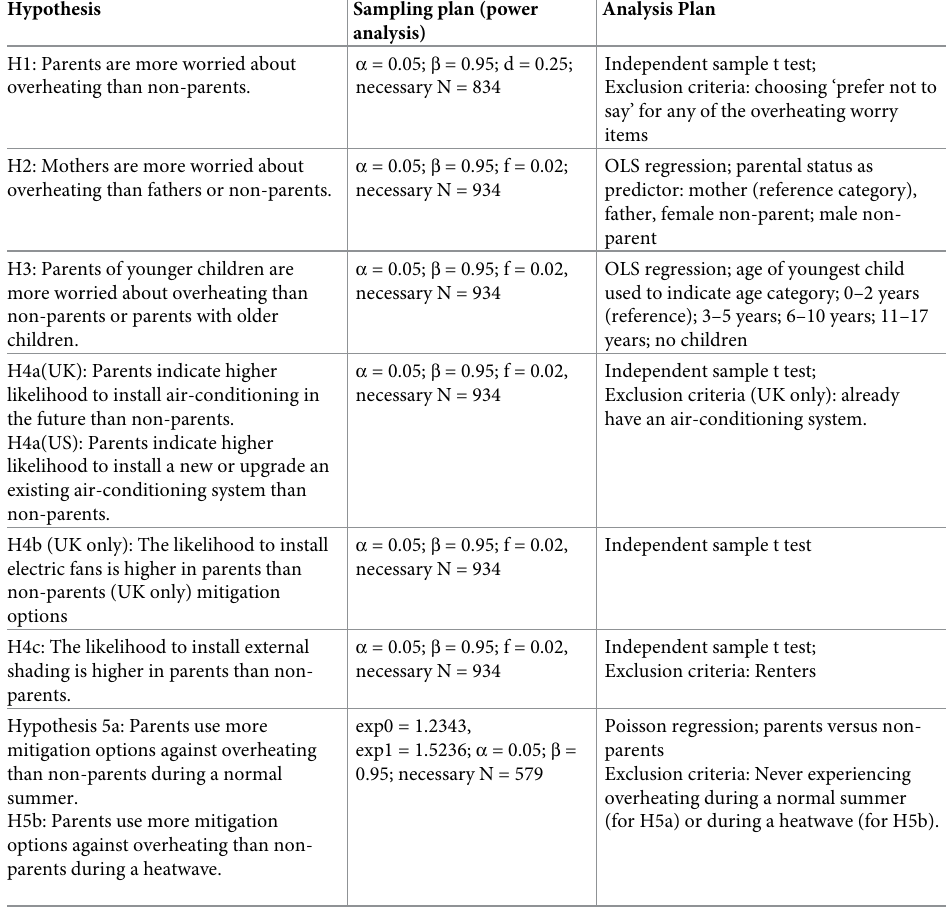
Table 7. Overview of hypotheses, power calculations and analysis plan. Hypothesis Sampling plan (power